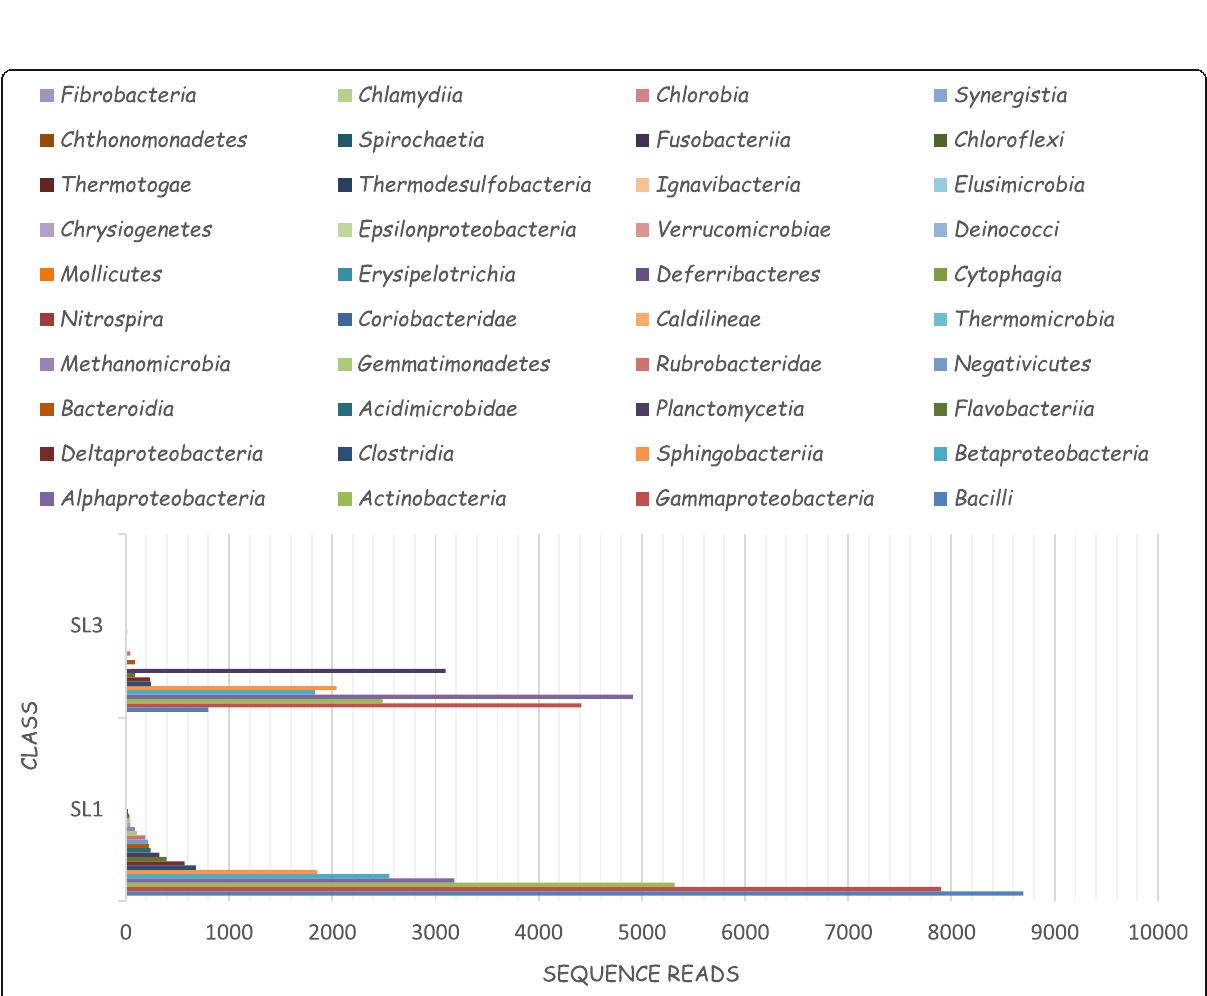
Fig. 2 Class classification of SL1 and SL3 metagenomes. Unclassified reads were not used for the analysis. All the classes detected in SL1 and SL3 metagenomes were